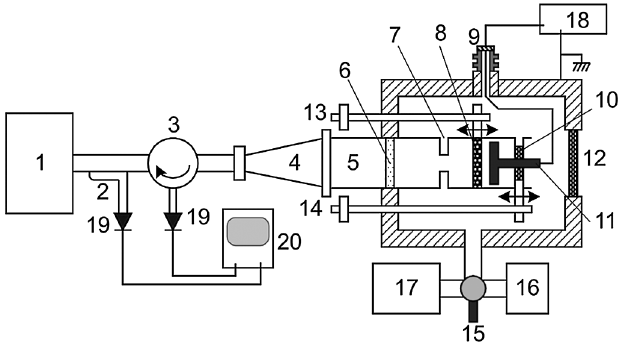
FIG. 2. Scheme of the experimental setup: 1—magnetron, 2— directional coupler, 3—circulator, 4—mode converter, 5—circu- lar waveguide, 6—microwave window, 7—diaphragm, 8— studied dielectric disk, 9—high-voltage input, 10—insulator, 11—electrode (back wall of the resonator), 12—observation window, 13 and 14—disk and electrode transfer mechanisms, respectively, 15—pressure gauge, 16—mechanical pump, 17— ion pump, 18—high-voltage source, 19—microwave detector, and